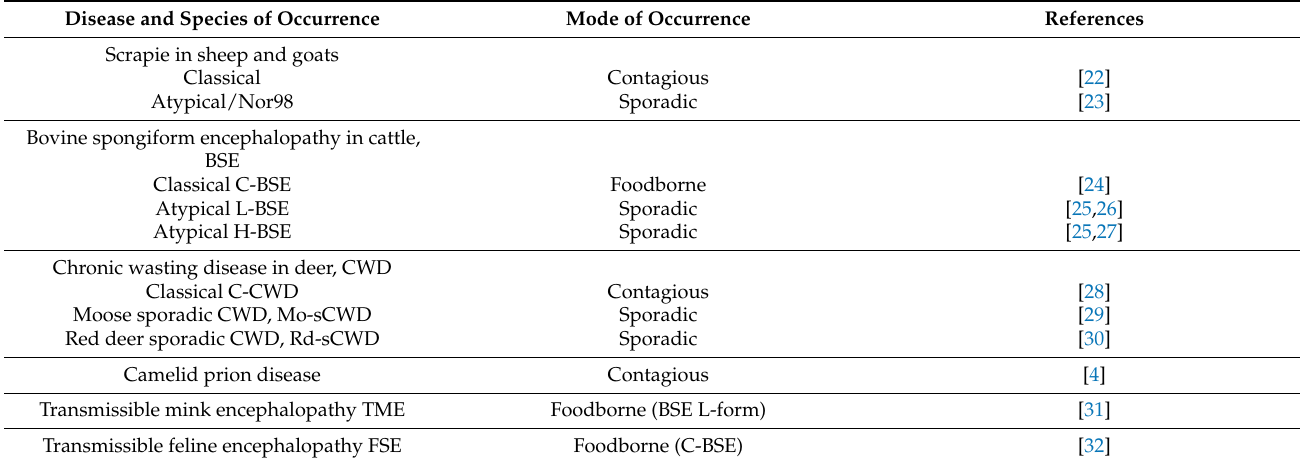
Table 2. Animal prion diseases and their epidemiological